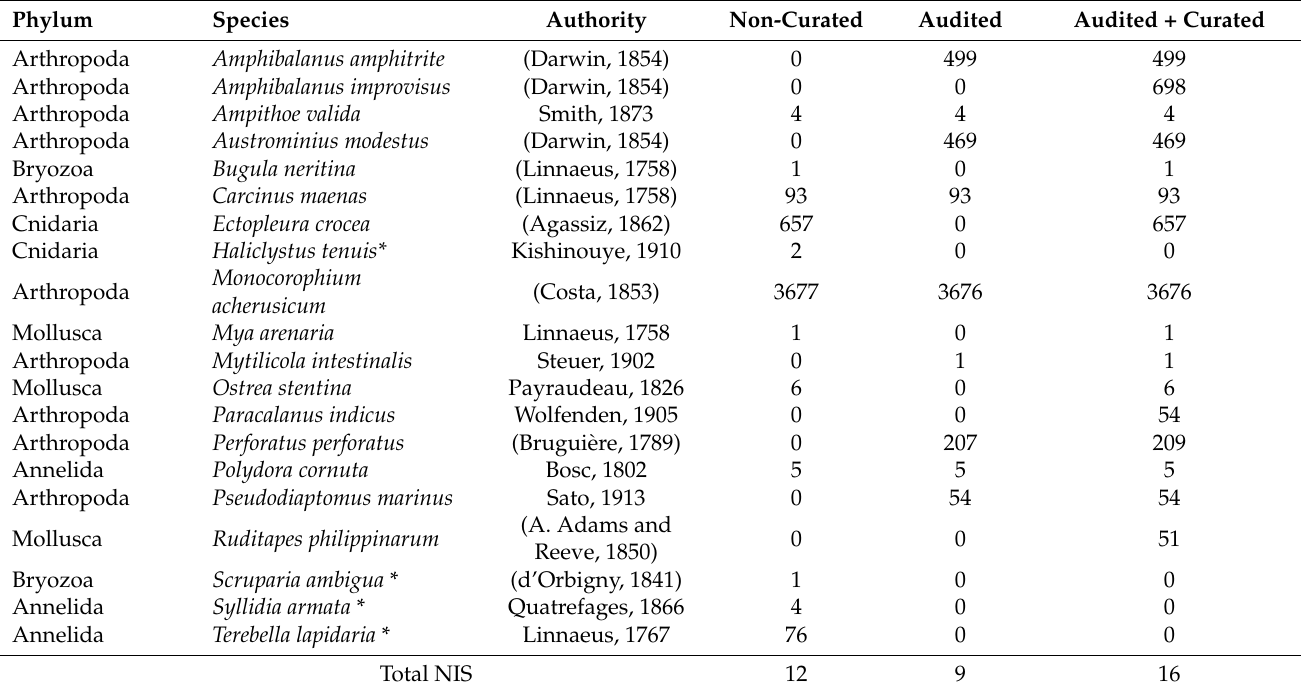
Table 1. Number of sequences (sum of reads of all the samples) per species detected with each of the three libraries: non-curated, audited, and curated, using the mBRAVE